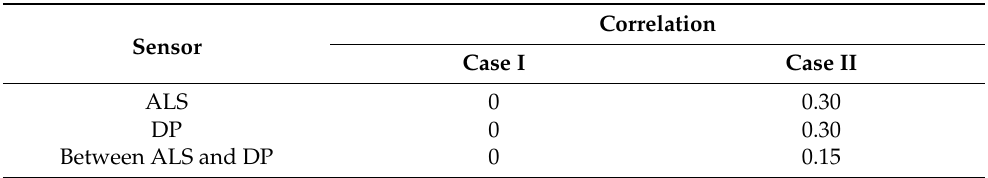
Table 2. Specified plot level correlations between the error terms according to Equation (1) for a given sensor and the corresponding cross-correlation between